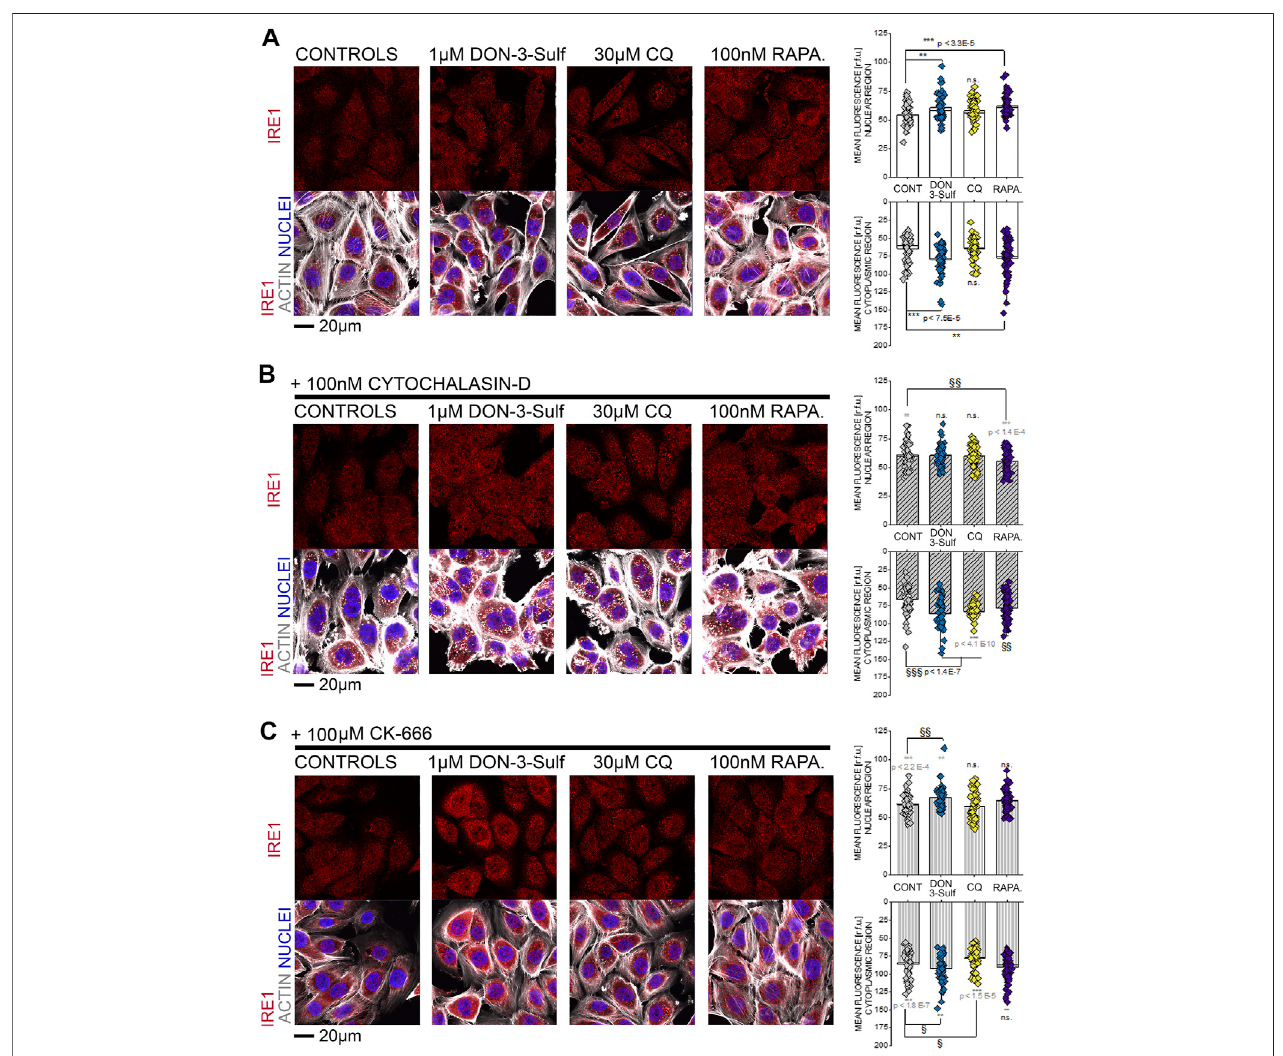
FIGURE 9 | T24 cells after immuno fl uorescence localization ofIRE1(red).Actin cytoskeleton isdepicted in white and nuclei in blue. (A) Representative appearance of cells in control conditions and after 24 h incubation with 1 µM DON-3-Sulf, 30 µM chloroquine (CQ), or 100 nM rapamycin (RAPA.). (B) Representative appearance of cells after24 hincubationwith100 nMcytochalasinDand1 µMDON-3-Sulf,30 µMchloroquine,or100 nMrapamycin(RAPA.). (C) Representativeappearanceofcellsafter24 h incubation with 100 µM CK-666 and 1 µM DON-3-Sulf, 30 µM chloroquine, or 100 nM rapamycin (RAPA.). Quanti fi cation of the signal intensity of IRE1 in the nuclear andcytoplasmicregionsexpressedasrelative fl uorescentunits(r.f.u.).Foreverycondition,dataresultfromthequanti fi cationof n > 50ROI.*indicatessigni fi cantdifferencein comparison to controls (black) or reference conditions without cytochalasin D and CK-666(gray) at the Student ’ s t -test (*: p ≤ 0.05; **: p ≤ 0.01; ***: p ≤ 0.001). § indicates signi fi cant difference in comparison to cytochalasin D/CK-666 controls at the Student ’ s t -test (§: p ≤ 0.05; §§: p ≤ 0.01 §§§: p ≤ 0.001; scale bar: 20 µm).